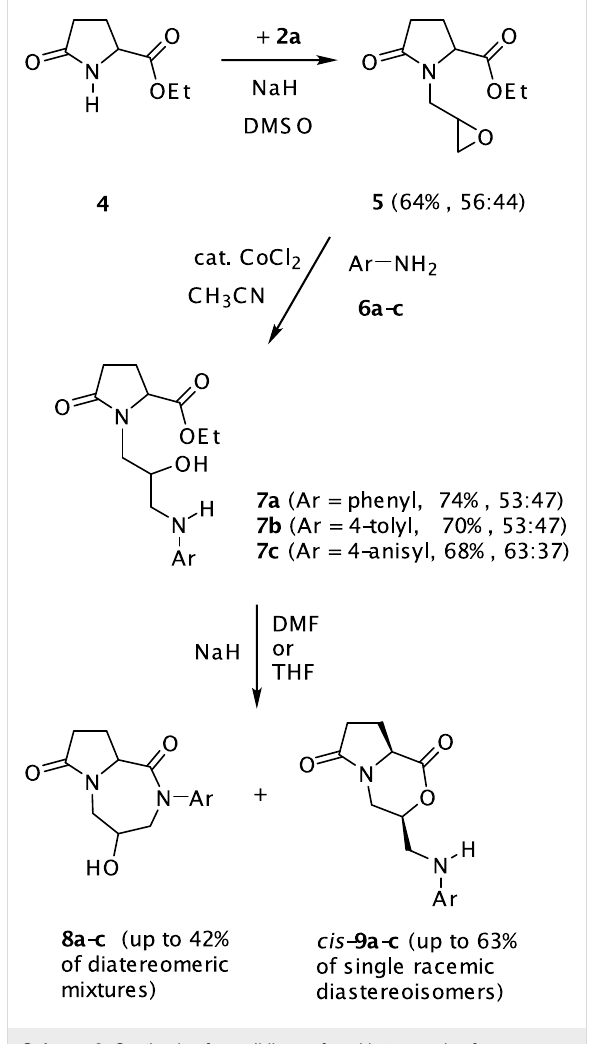
Scheme 2: Synthesis of pyrrolidinone-fused heterocycles from a glycidyl substituted pyroglutamic acid ester 5 (ratio of diastereoi- somers determined by 1 H NMR